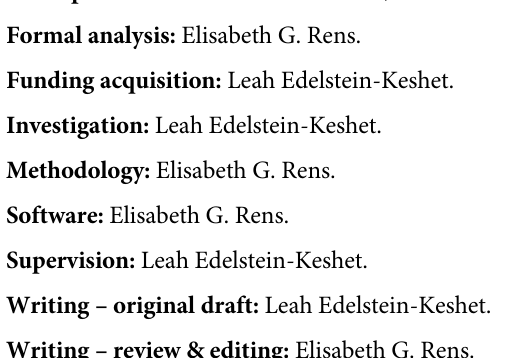
main text and the force fields for 2-5 are given in S11 Fig. (PDF) S1 Movie. Forces computed over time for motion of the round cell. A time sequence of cell motion and force fields from [26] showing experimental data (blue) and CPM (magenta) force fields. The CPM parameters were as in S11 Fig and row 1 of S2 Table. S2 Movie. Forces computed over time for motion of the polarized cell. As in S1 Movie, but for the polarized